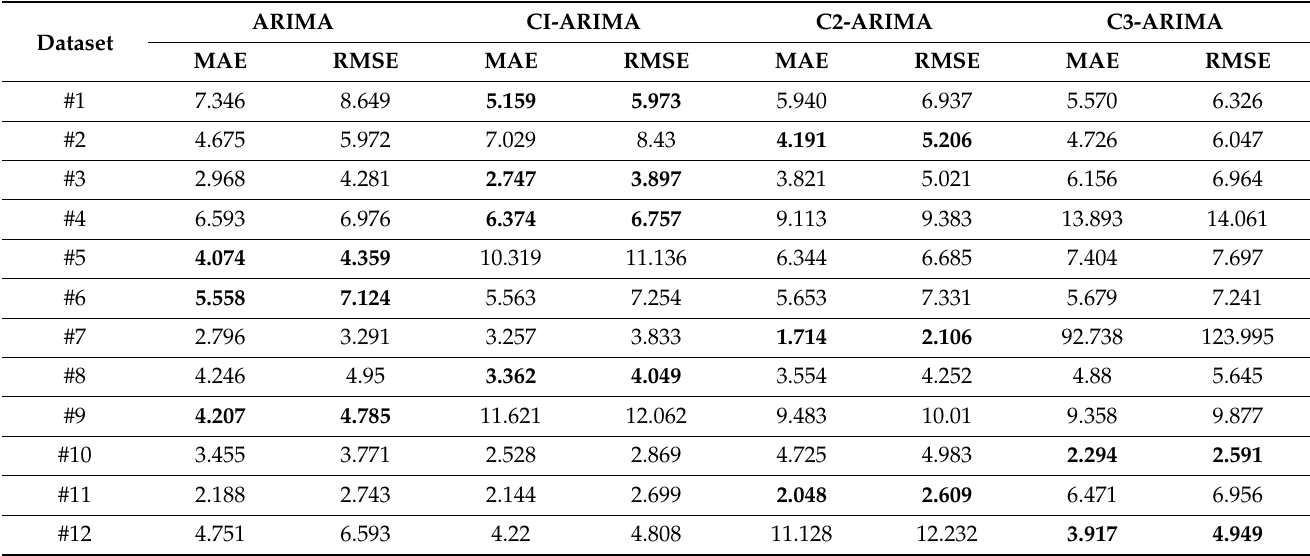
Table 4. MAE and RMSE values using the ARIMA and clustered ARIMA models [21].